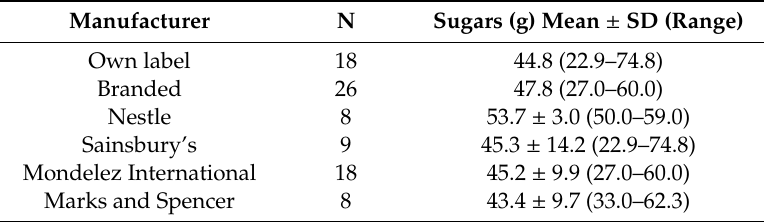
Table 2. Sugar content in chocolate confectionery by manufacturer per 100 g in